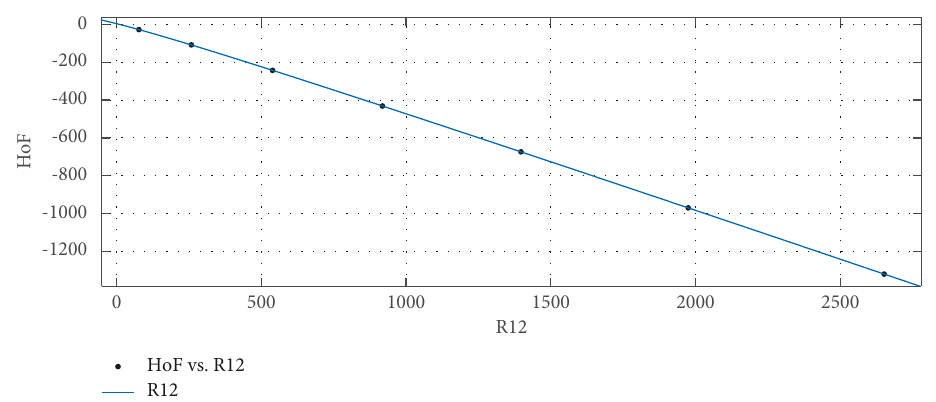
Figure 5: R ( 1/2 ) vs.